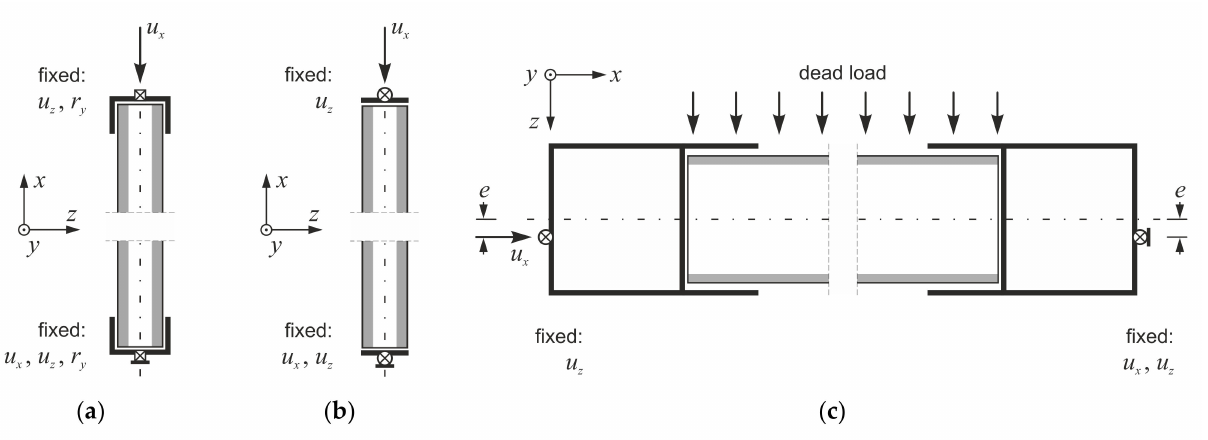
Figure 6. Boundary conditions used in simulations of ( a ) L1, L2, ( b ) L3, ( c ) e0, e1, e2 tests. The computations were realized as geometrically nonlinear static analysis.